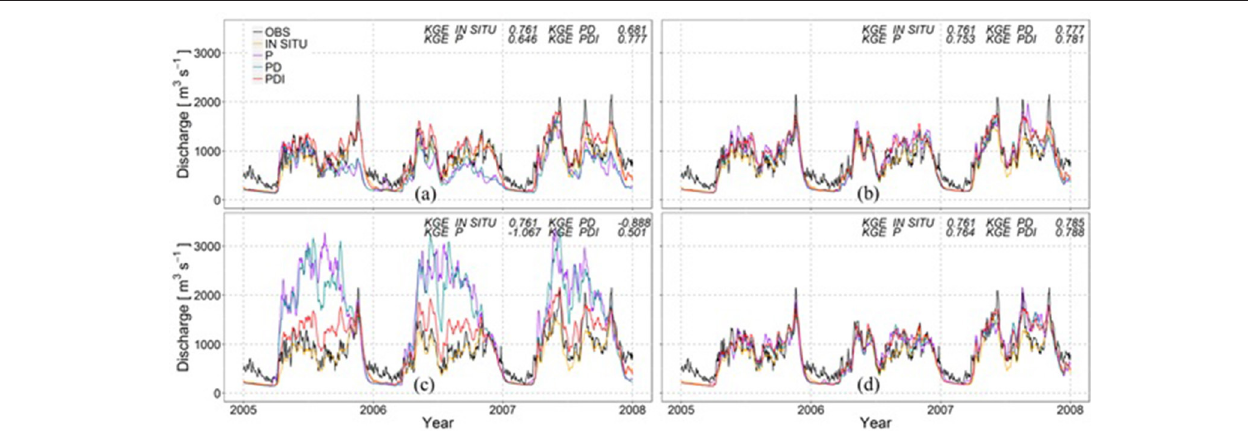
FIGURE 7 | Daily observed discharge (black) and estimated discharge (orange, purple, blue, and red) time series at La Esperanza station (27037010) when the model was forced with (a) CMORPH, (b) MSWEP, (c) PERSIANN, and (d) TRMM for the 2005–2007 period. The orange lines represent discharge estimates when in situ precipitation data was used. The purple, blue, and red lines represent discharge estimates when satellite-based precipitation data was used at 25km ( P ), at 1km ( PD ), and at 1km merged with in situ observations ( PDI ).